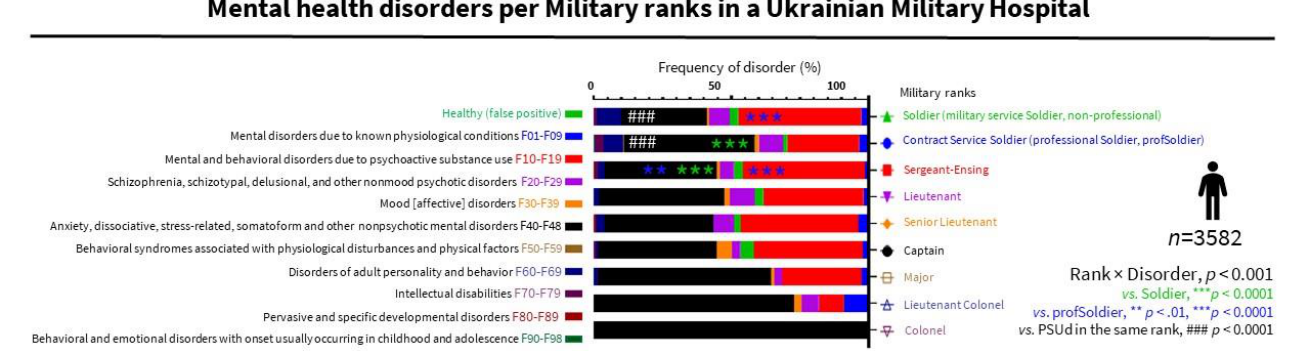
Figure 3. Mental health disorders per military ranks. Left axis: ICD-10-CM categories. Right axis: Military ranks. Statistics: Frequencies (%), Chi-square (see depicted using colors, in the inset).